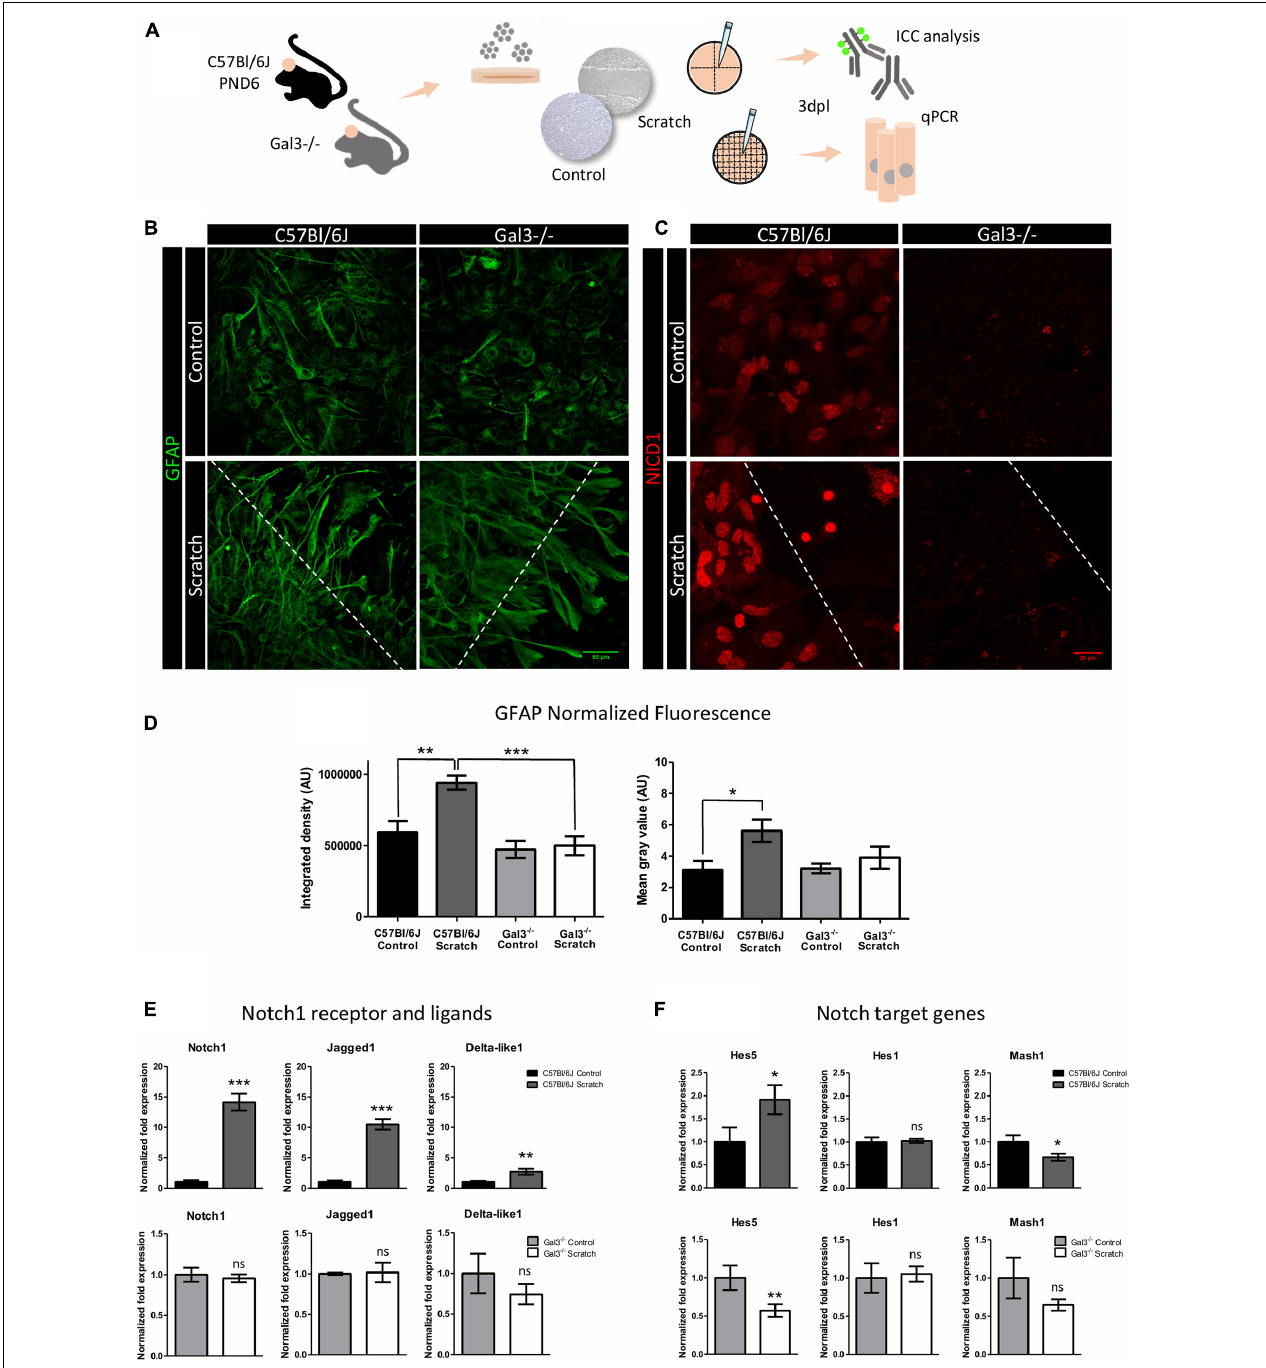
FIGURE 4 | Notch1 signaling is impaired in Gal3 − / − astrocytes. (A) Experimental design: C57Bl/6J and Gal3 − / − astrocytes were scratch-reactivated. Protein and gene expression were analyzed by immunocytochemistry and qPCR. (B) Representative Z-stack confocal images of GFAP staining in C57Bl/6J and Gal3 − / − reactive and non-reactive astrocytes. C57Bl/6J and Gal3 − / − reactive astrocytes project cellular processes to the lesion border. Scale bars: 50 µ m. (C) Gal3 − / − astrocytes do not activate Notch1 signaling, as shown by total absence of nuclear NICD1 immunostaining. In contrast, C57Bl/6J reactive astrocytes display strong nuclear NICD1 immunostaining, suggesting activation of Notch1 signaling. Dashed lines indicate scratch border. Scale bar: 20 µ m. (D) GFAP normalized fluorescence analysis of C57Bl/6J and Gal3 − / − control and scratched-astrocytes. Values are reported in integrated density (D,left) and mean gray value (D,right) . AU = arbitrary units (*** p ≤ 0.001; ** p ≤ 0.01; * p ≤ 0.05). qPCR analysis of (E) Notch1 receptor and ligands and (F) mRNA expression levels of Notch1 target genes in C57Bl/6J and Gal3 − / − astrocytes. Values are relative to control group and are expressed in fold change. mRNA expression level was normalized to Gapdh . (*** p ≤ 0.001; ** p ≤ 0.01; ns = not significant; unpaired Student’s t -test; n = 3 biological and technical replicates).